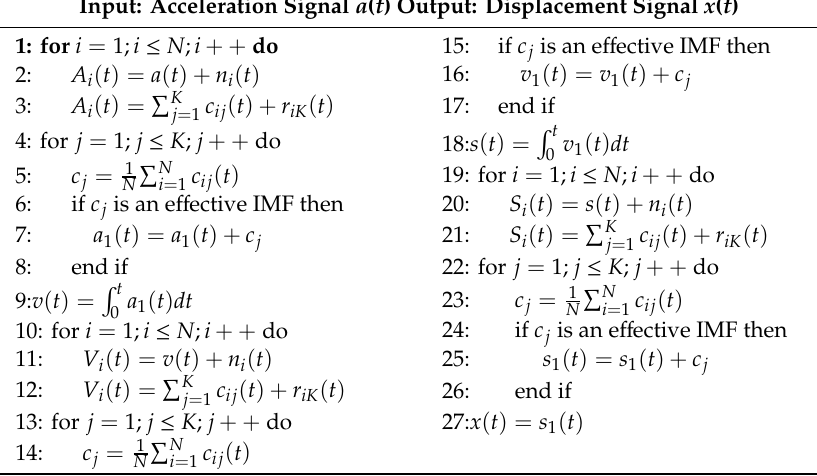
Table 1. Displacement reconstruction